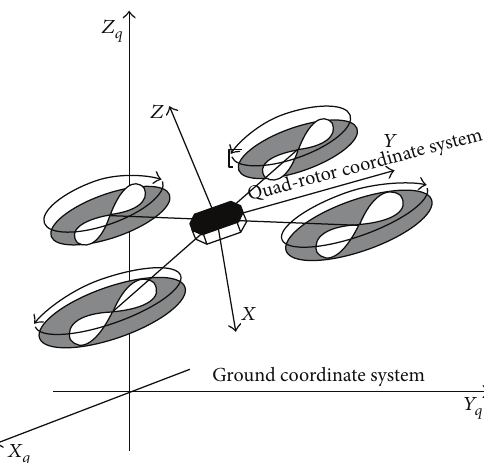
Figure 2: Relationship between the quad-rotor coordinate system and the ground coordinate